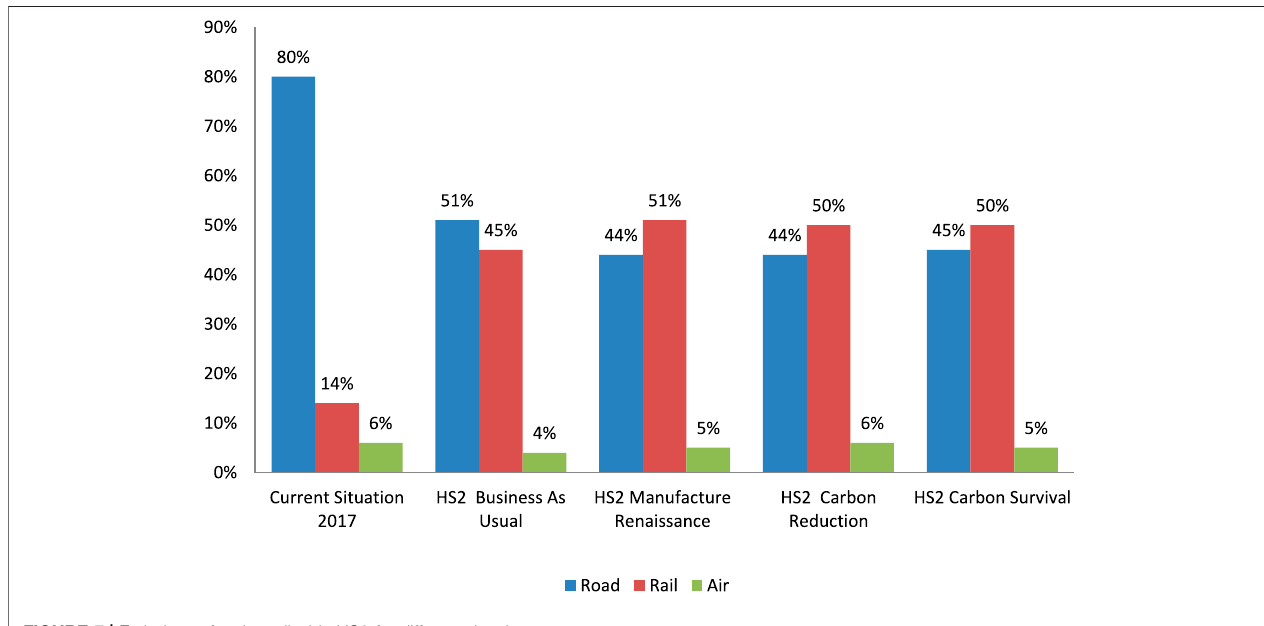
FIGURE 7 | Emissions of carbon dioxide HS2 for different